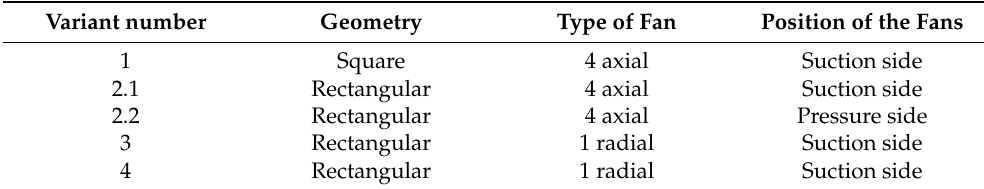
Table 2. Overview of simulated variants with indications about the type of fans adopted and their position related to the